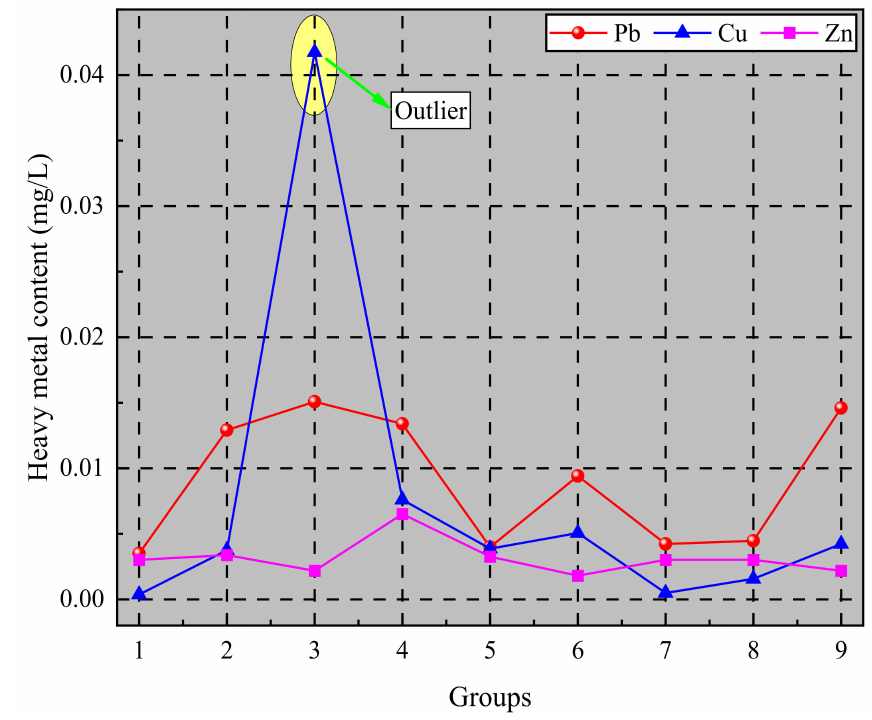
Figure 11. Leaching orthogonal experimental results. Table 5. Range analysis of heavy metal leaching from fly-ash-based